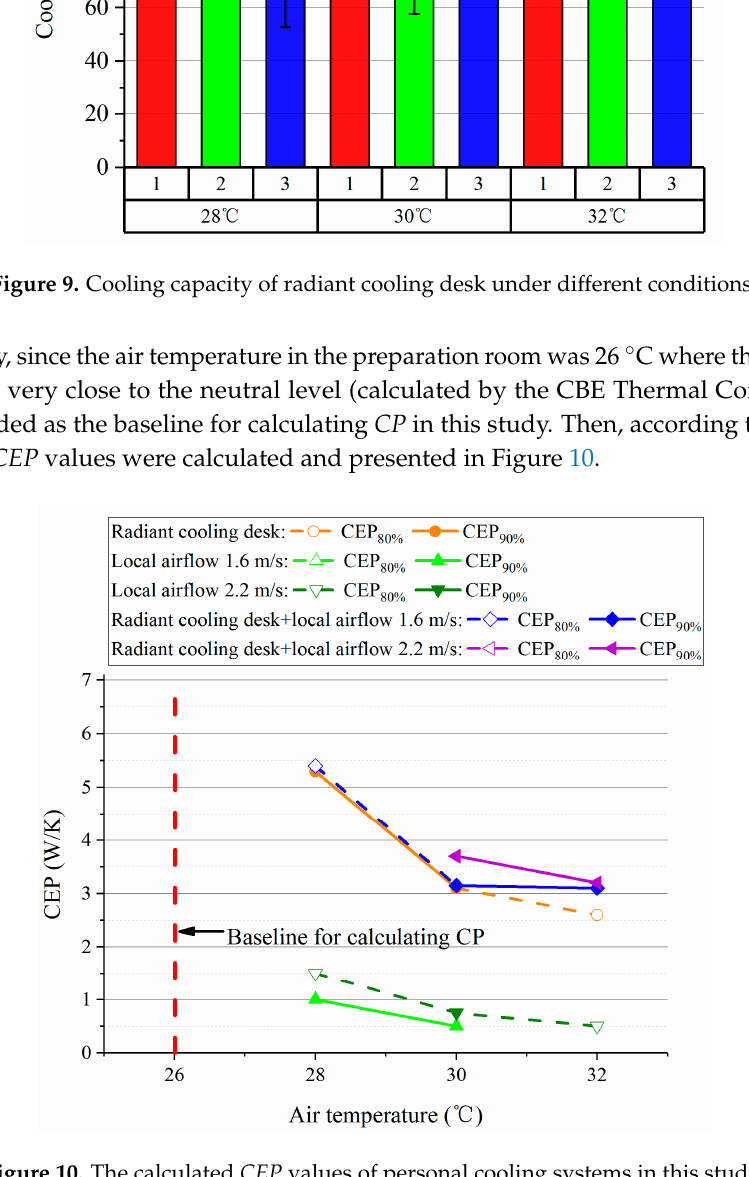
Figure 10. The calculated CEP values of personal cooling systems in this study.